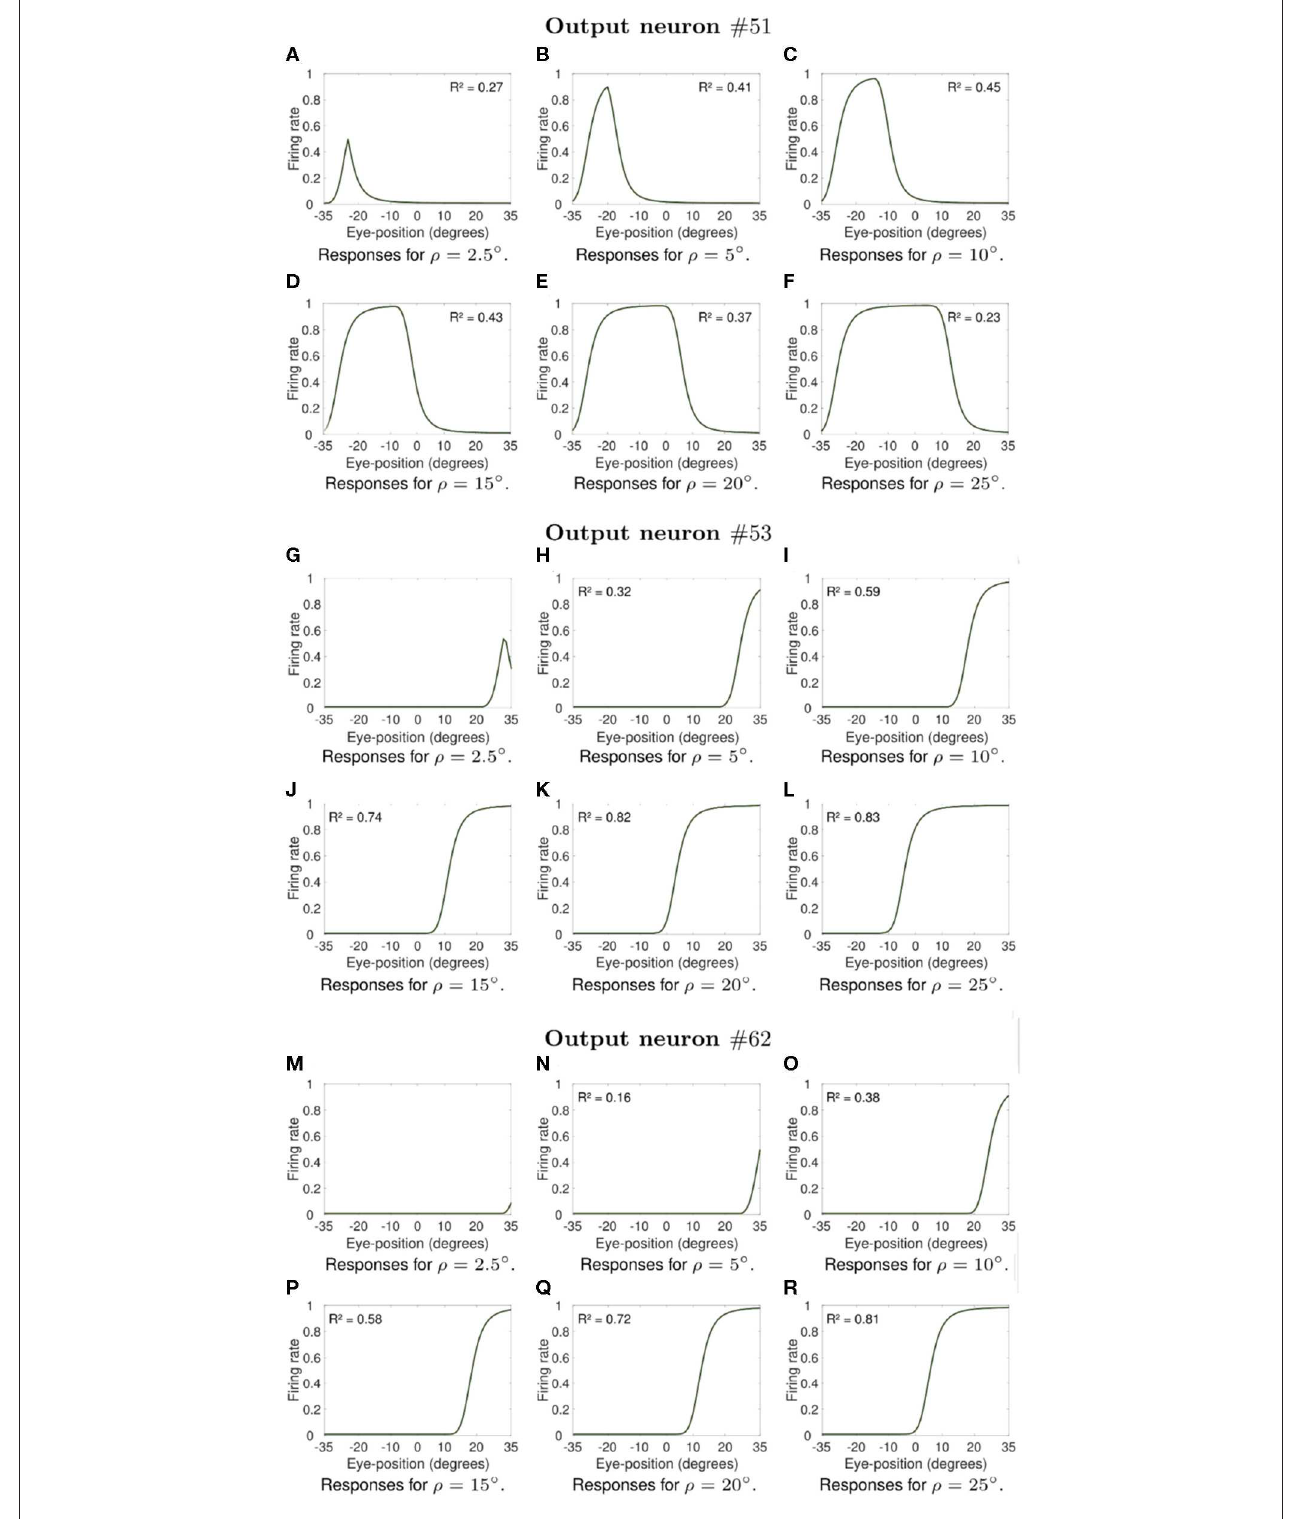
FIGURE 8 | Influence of varying the width ρ of the eye position tuning curve in the self-organizing model. The subplots shows extra examples of how the width ρ of the eye position tuning curve affected the self-organization of the visual responses of output neurons # 51, neuron # 53, and neuron # 62. Similar to Figure 7 , the visual stimulus was presented at retinal location − 10 ◦ and the eyes shifted from [ − 35 ◦ ,35 ◦ ] in integer steps of one degree. Table 2 gives the simulation parameters for the model. The value of ρ for training and testing is indicated for each subplot. These subplots show that an increase in the value of ρ changes the firing rate